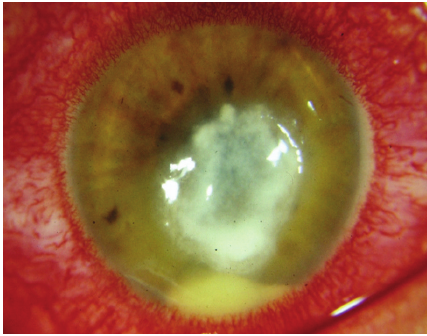
Figure 10: Candida albicans keratitis in an 8-month-old female.